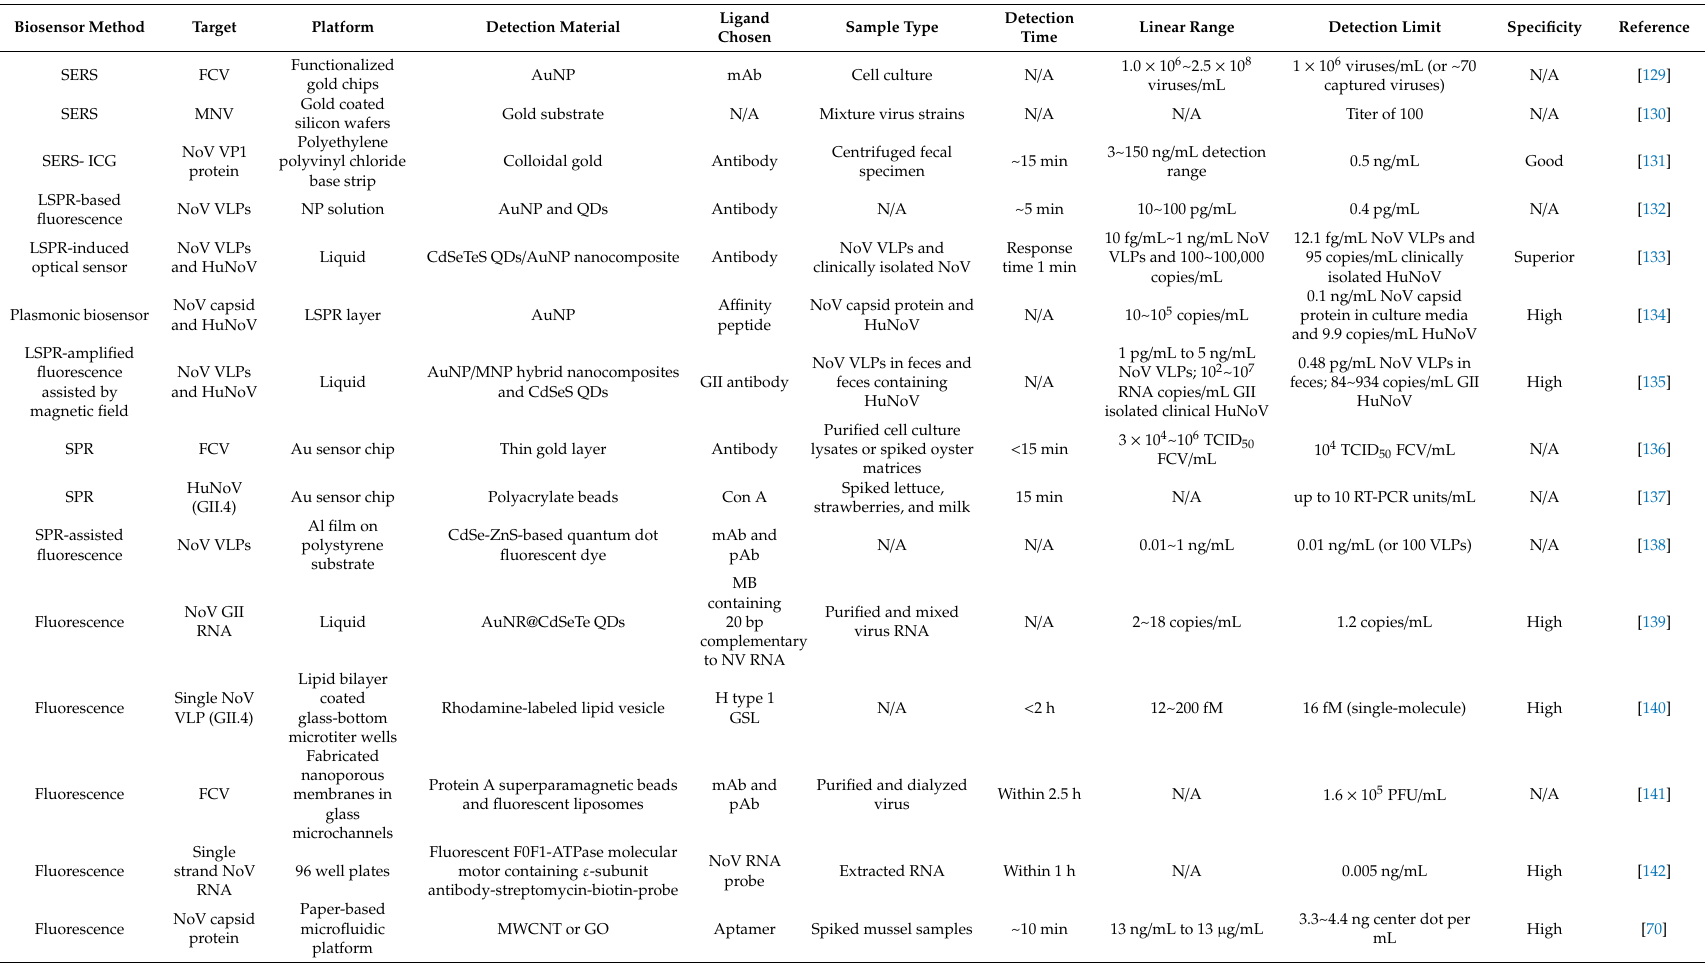
Table 3. Biosensor methods for detection of norovirus and its